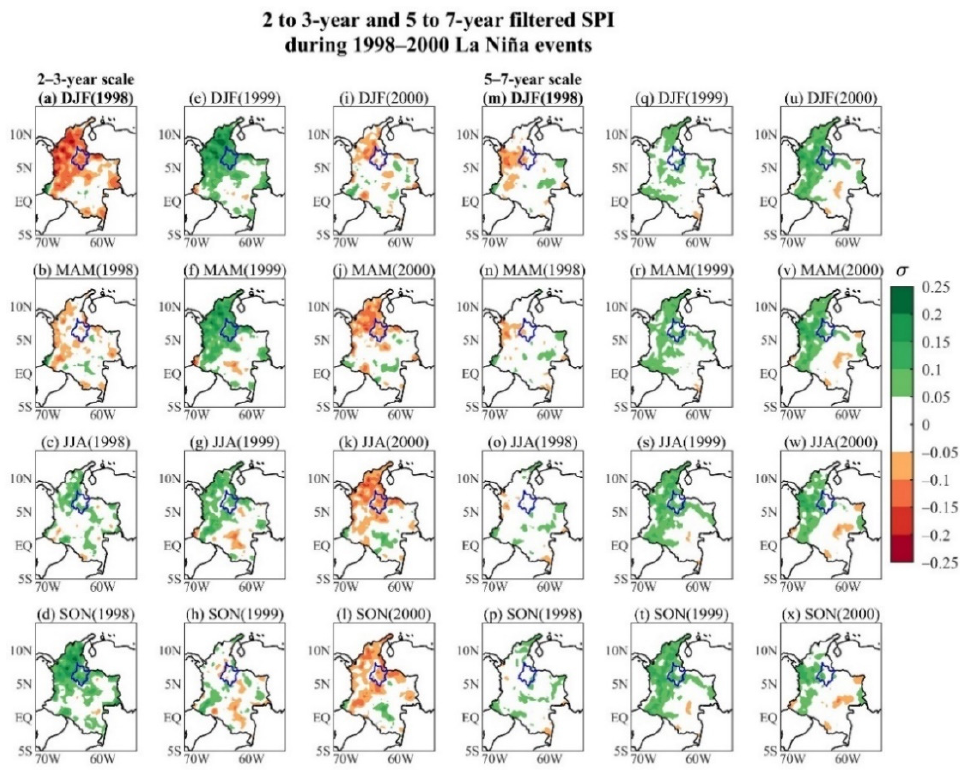
Figure 8. Seasonal standardized precipitation index (SPI) filtered at ( a – l ) biannual 2–3-year and ( m – x ) interannual 5–7-year scales between DJF 1998 and SON 2000.